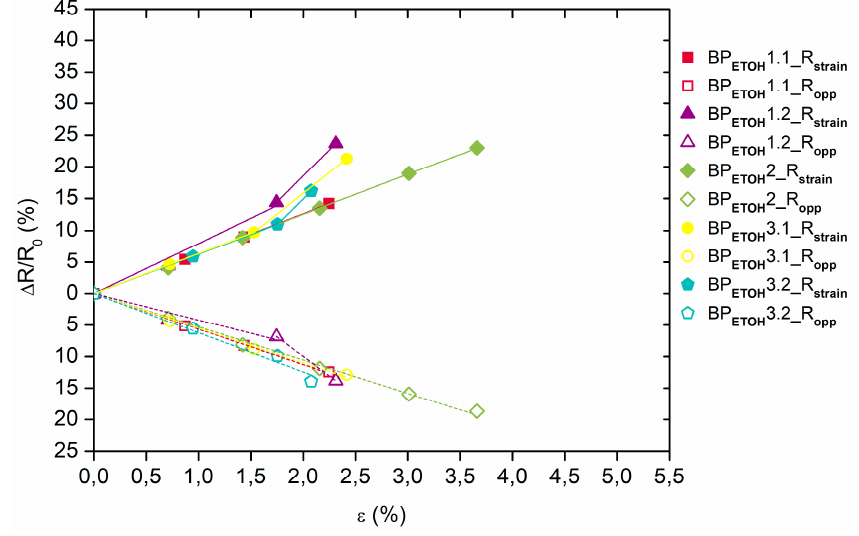
Figure 5. Relative electrical resistance ∆ R/R 0 as function of the strain ε for the BP ETOH /PI samples (R strain and R opp values in axial strain and opposite (transverse) directions, respectively).